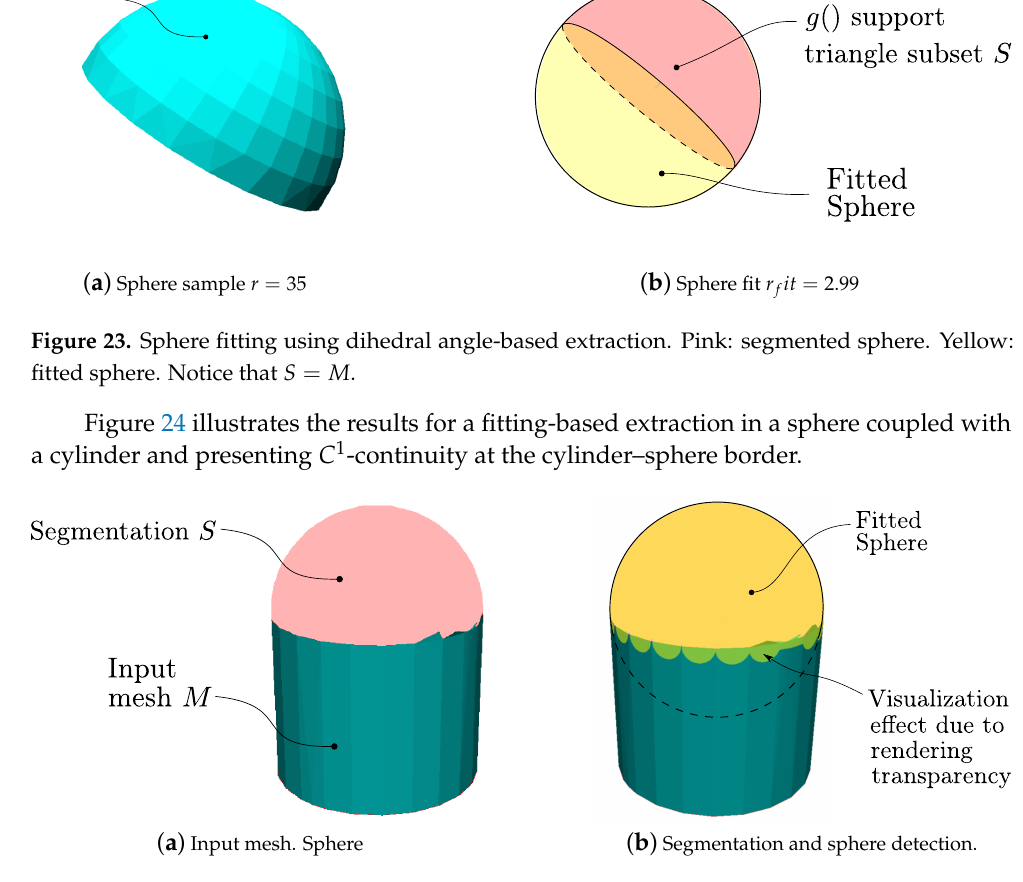
Figure 24. Sphere fit. Fitting-based S extraction. Pink: extracted S support subset. Yellow: fitted g () . The process leaves out of S few sphere triangles at the C 1 border with M − S . However, it succeeds in rejecting inclusion in S of triangles actually belonging to the cylinder. Table 8. SPHERE Fit. Set vs. found parameters. Test 1: S extraction based on dihedral angles. Test 2: fitting-based S